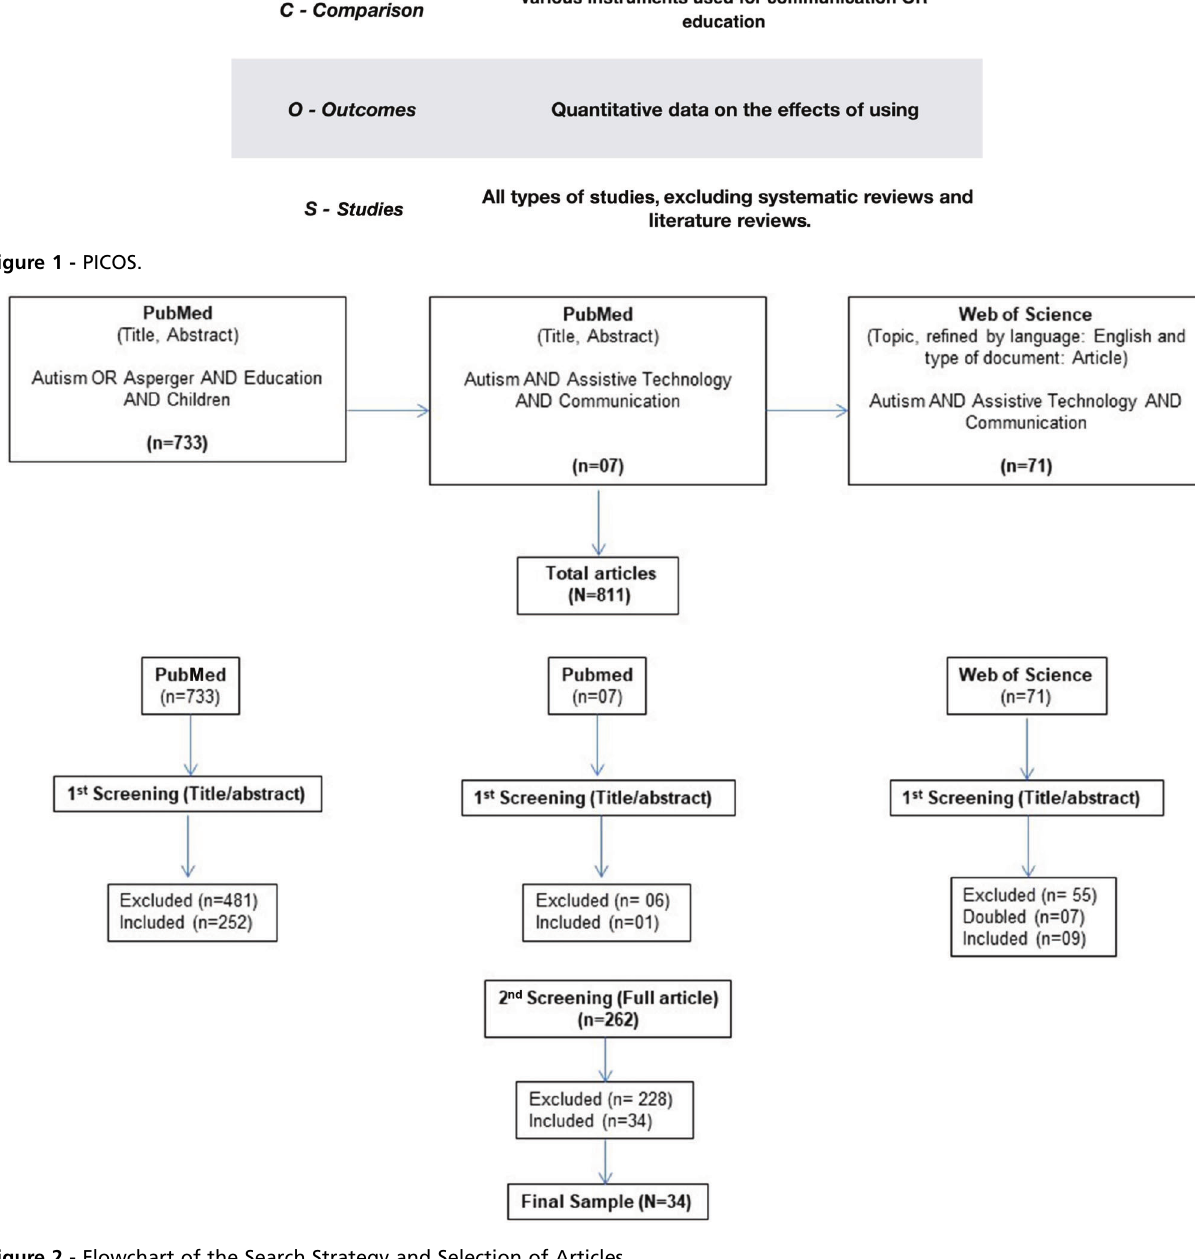
Figure 2 - Flowchart of the Search Strategy and Selection of Articles. Table 1 - Search